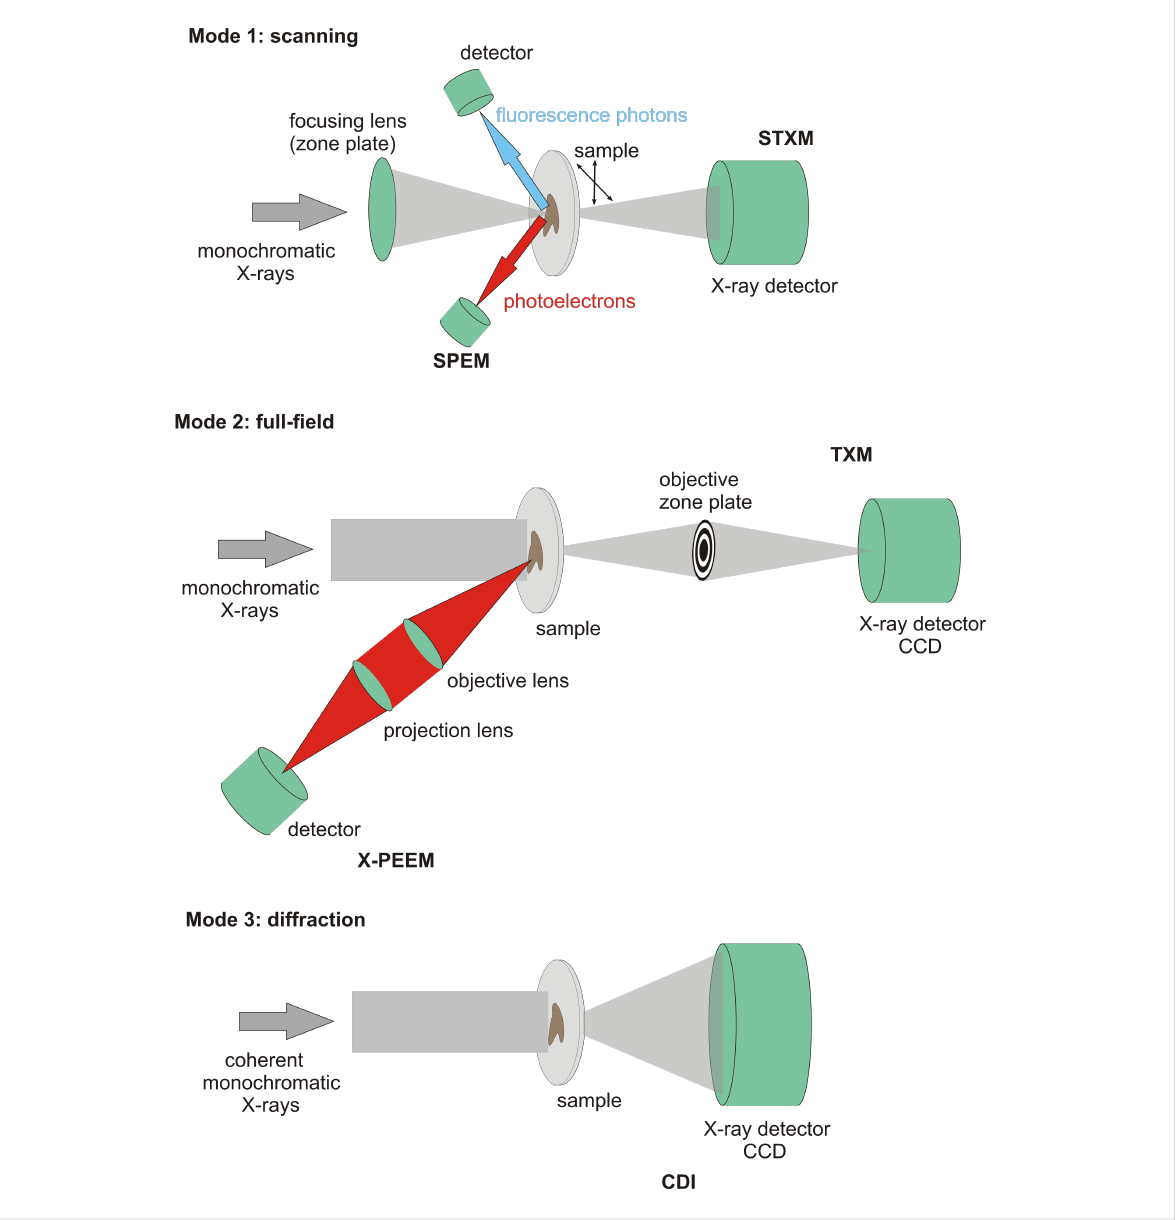
Figure 1: Schematic layout of general modes of soft X-ray microscopy. STXM and SPEM are focused probe methods, whereas TXM and X-PEEM are direct imaging methods. CDI needs computer algorithms to reconstruct an image from the recorded diffraction pattern.